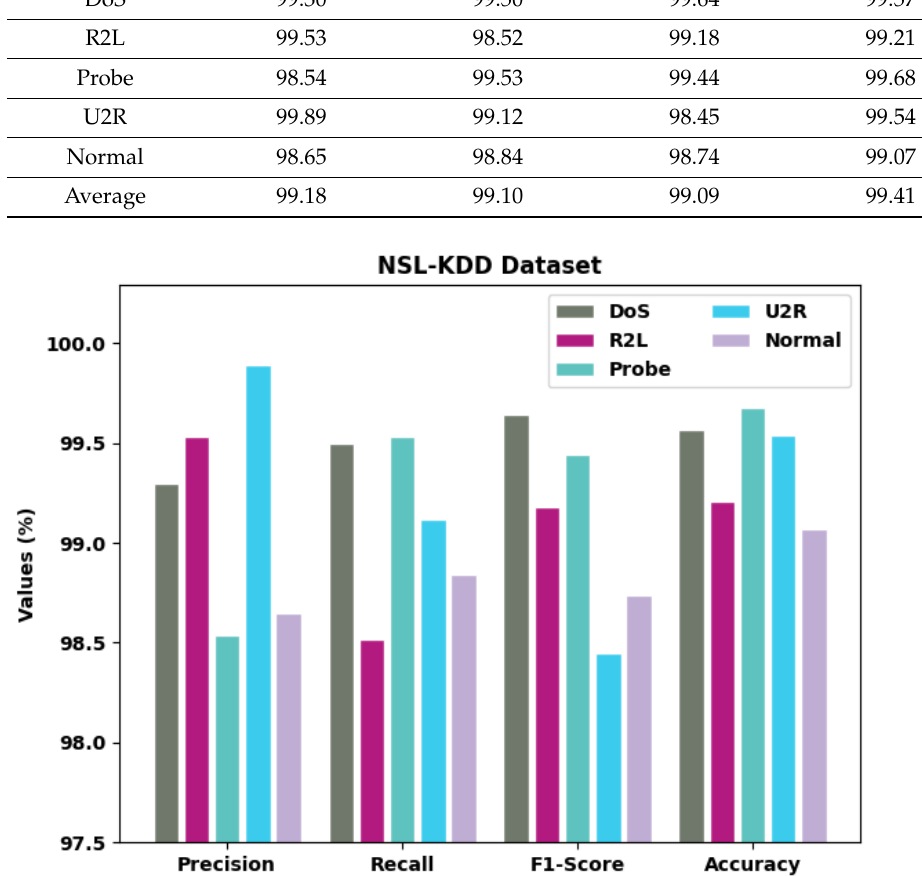
Figure 3. Result analysis of OMLIDS-PBIoT technique under NSL-KDD dataset.